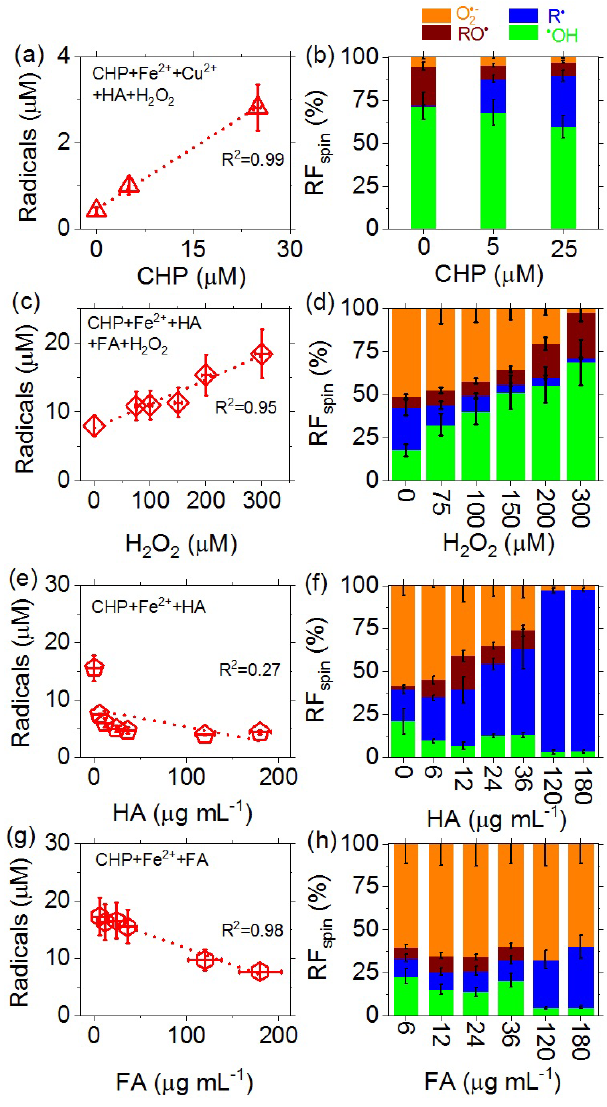
Figure 6. (a, c, e, g) Total concentrations and (b, d, f, h) relative fractions (RF spin ) of different types of radicals (spins) observed in aqueous mixtures of Fe 2 + , Cu 2 + , humic acid (HA), fulvic acid (FA), cumene hydroperoxide (CHP), and H 2 O 2 serving as surrogate species for redox-active components of PM 2 . 5 . (a, b) 0–25µM CHP, 43µM Fe 2 + , 3µM Cu 2 + , 4µgmL − 1 HA, 7µM H 2 O 2 (CHP + Fe 2 + + Cu 2 + + HA + H 2 O 2 ). (c, d) 100µM CHP, 300µM Fe 2 + , 100µgmL − 1 HA, 80µgmL − 1 FA, 0–300µM H 2 O 2 . (e, f) 100µM CHP, 300µM Fe 2 + , 0–180µgmL − 1 HA (CHP + Fe 2 + + HA). (g, h) 100µM CHP, 300µMFe 2 + , 6–180µgmL − 1 FA (CHP + Fe 2 + + FA). The error bars represent the uncertainties in the EPR signal integration ( y axis) and solute concentration ( x axis),